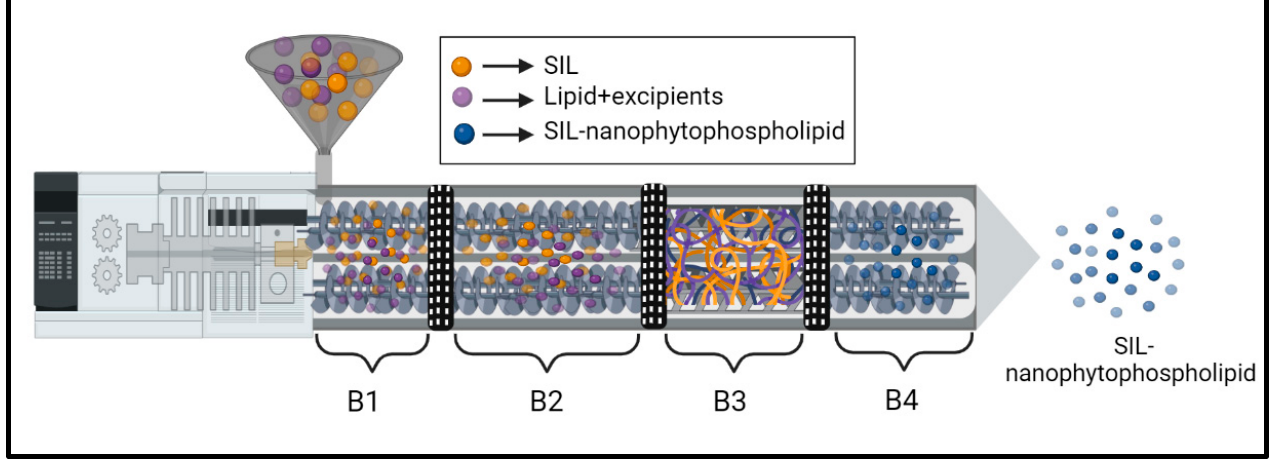
Figure 1. An illustration of TSP to obtain SIL-nanophytophospholipid. B1, B2, B3 and B4 represent the barrel heating zone. Table 1. Optimization of working formula to prepare nanophytophospholipid batches of SIL using TSP.